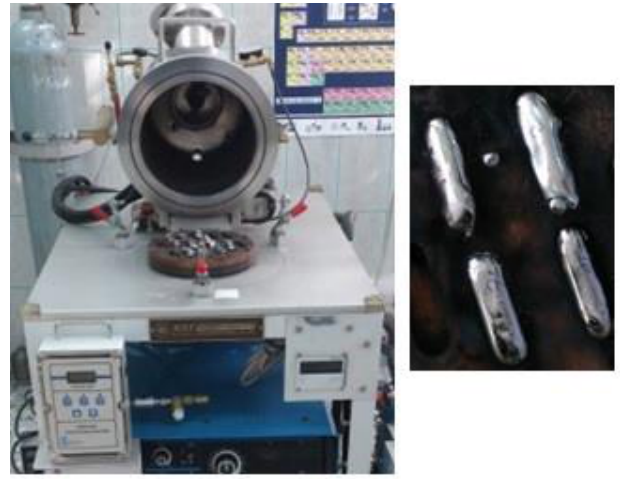
Figure 3. VAR furnace used in the experiments and the samples obtained.